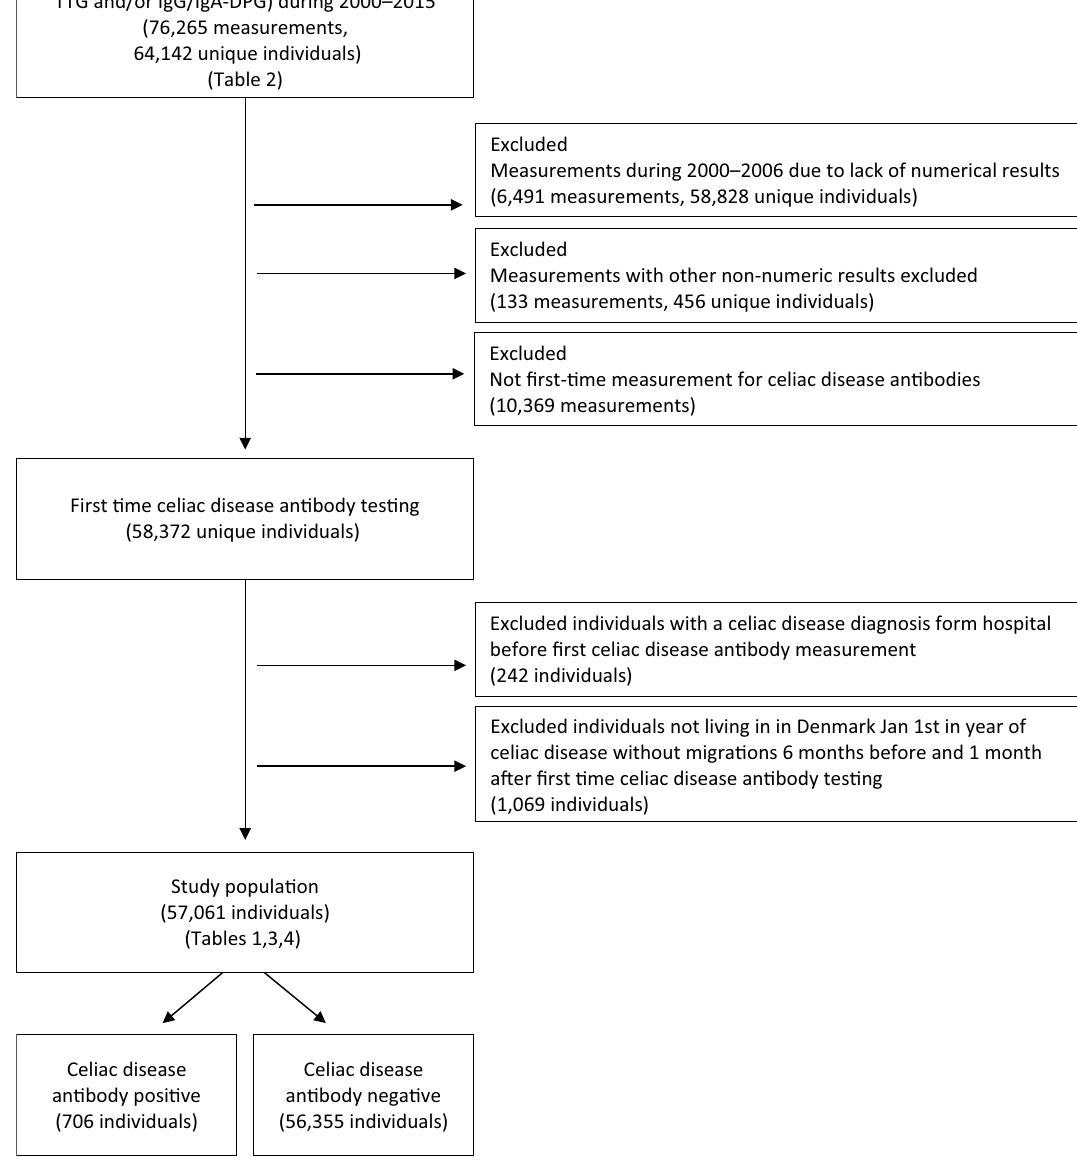
Figure 1. Flow diagram, description of the selection of the study